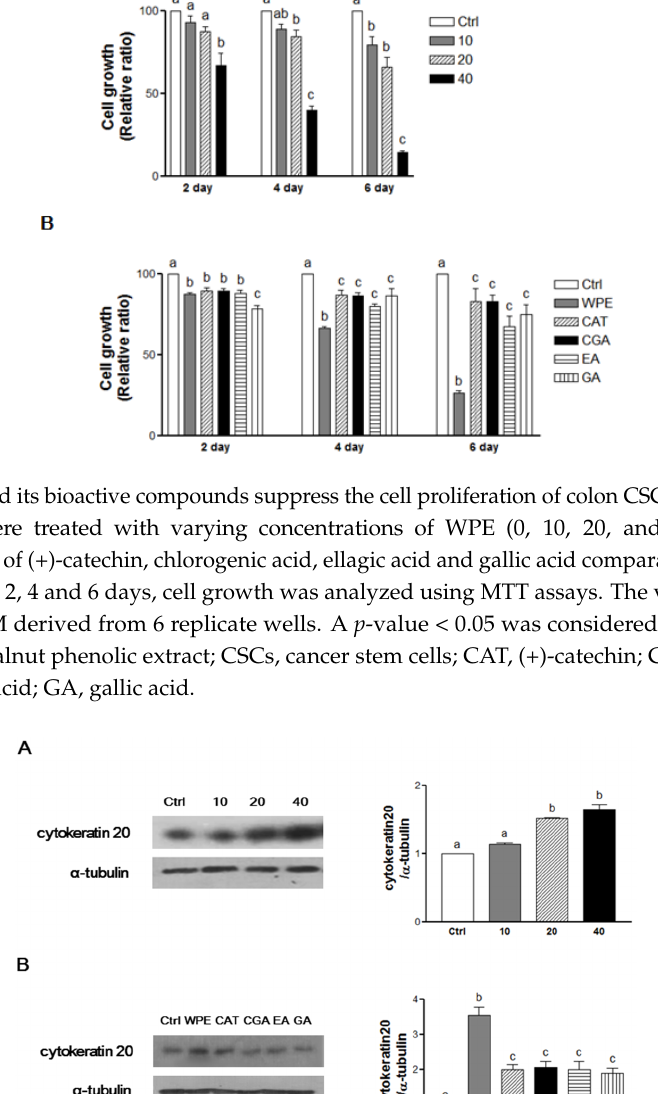
Figure 2. WPE and its bioactive compounds suppress the cell proliferation of colon CSCs.